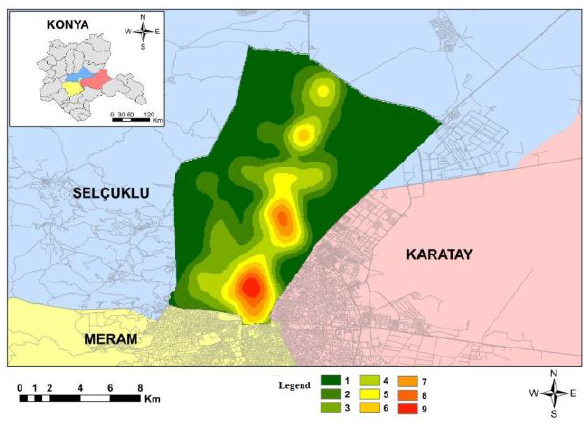
Figure 6. Educational facilities density analysis